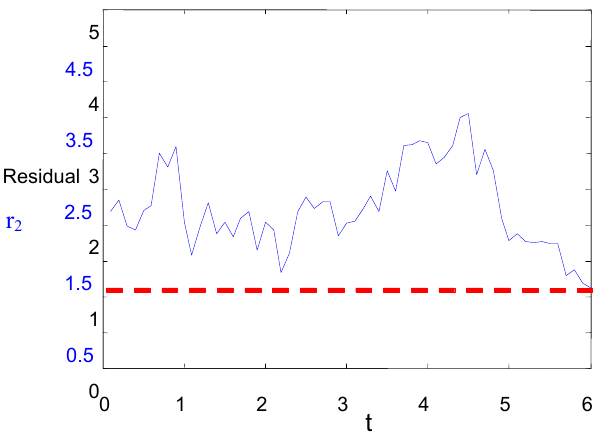
for position estimation sequence with initial standard deviations of Figure 8. Residual r 2 UDev = 2.3 and VDev = 1.5, and threshold level of